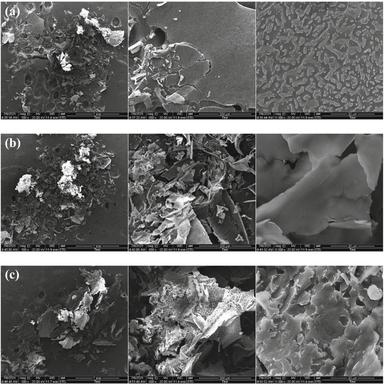
SEM observation on LZ-MPS (a), MC-MPS (b), and G-MPS (c) 100×, 600×, and 5000× magnified pictures.